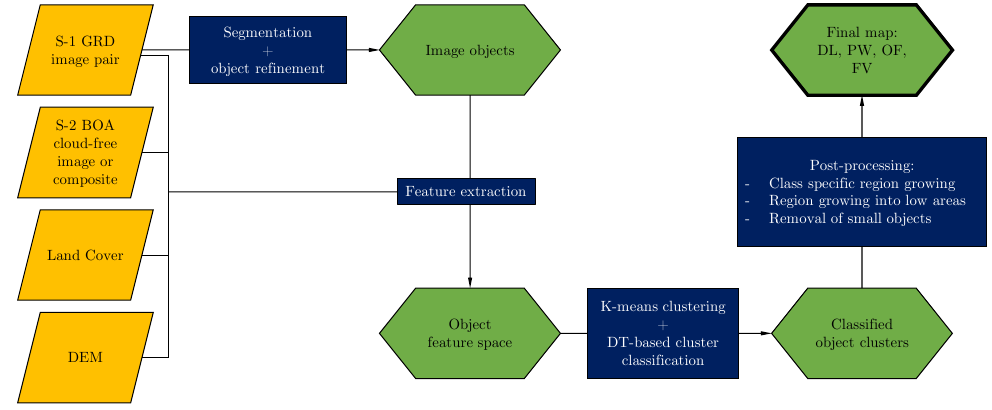
Figure 2. Overview of the methodological framework, resulting in a multi-class classification discriminating dry land (DL), permanent water (PW), open flood (OF), and flooded vegetation